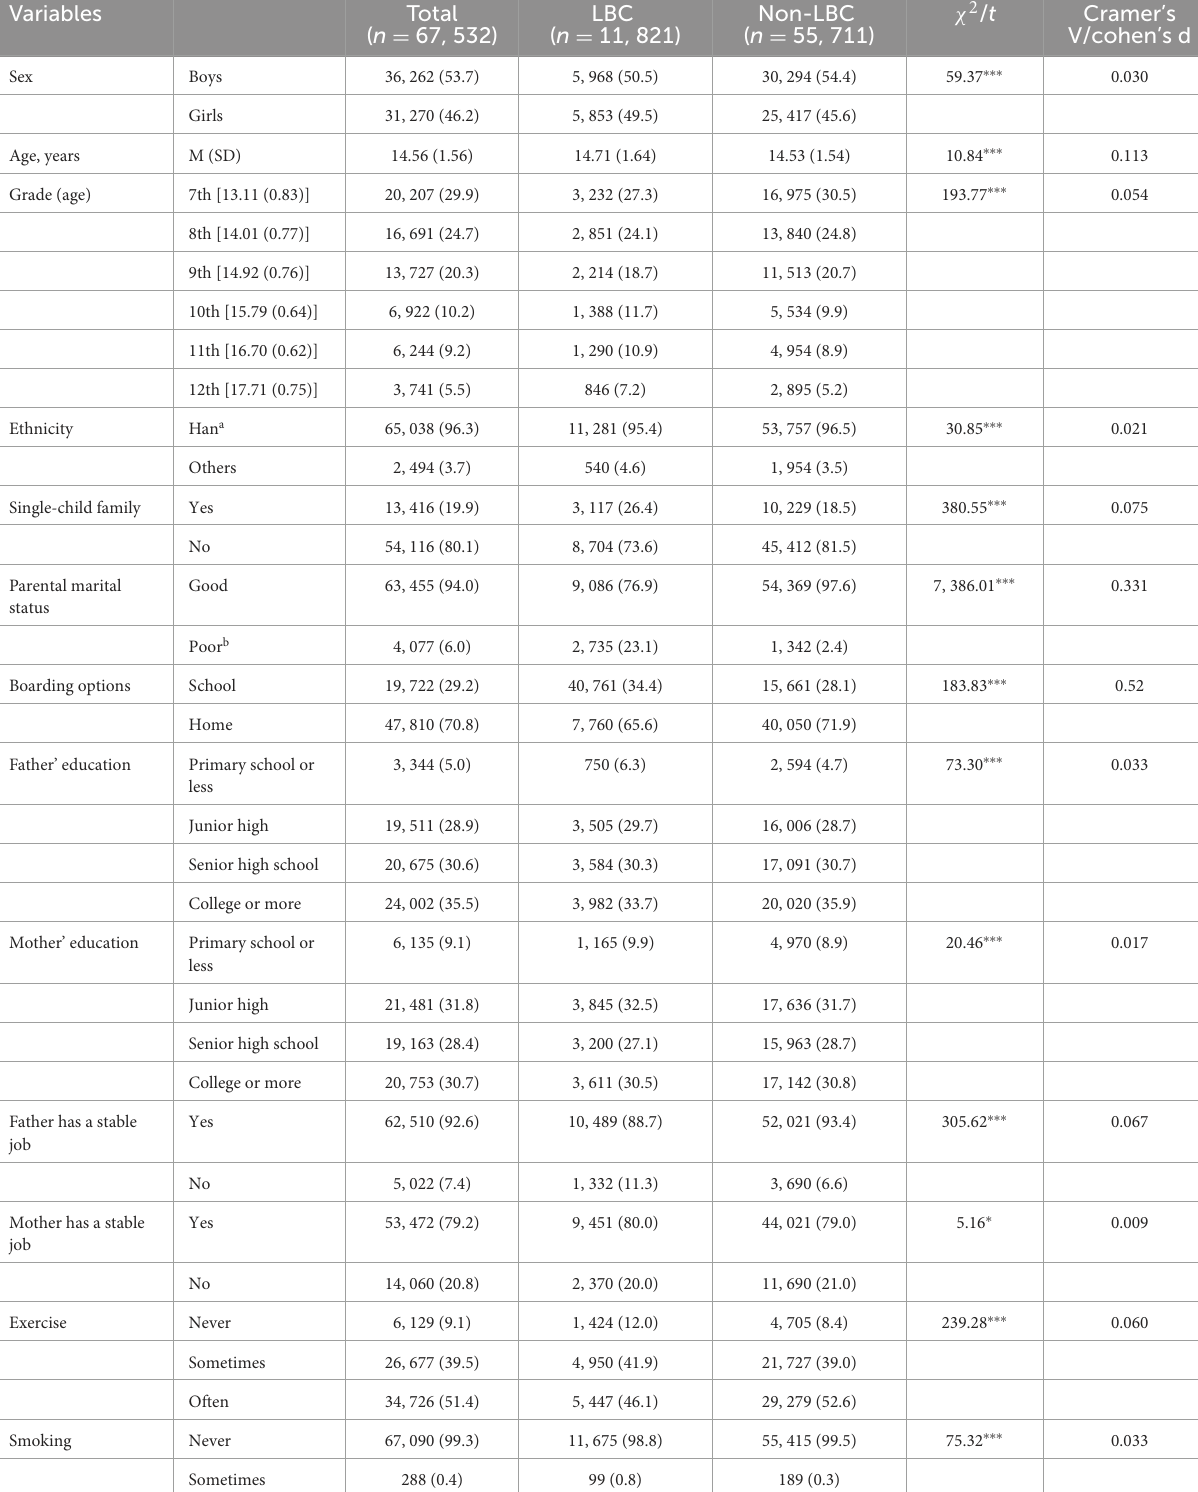
TABLE 1 Demographic characteristics of participants and differences between left-behind children (LBC) and non-LBC.